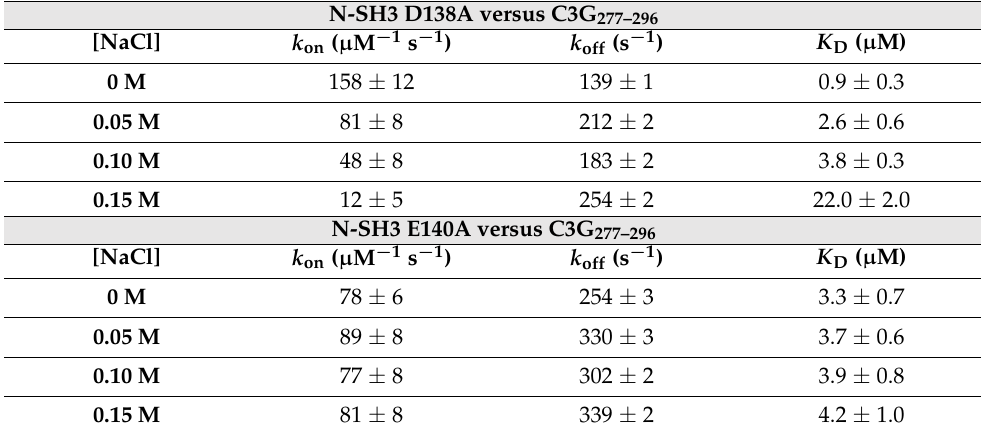
Figure 5. ( Top left ) Kinetic binding experiments performed by mixing a constant concentration of dansylated C3G 277–296 peptide (0.5 µ M) versus increasing concentrations of N-SH3 D138A at different ionic strength conditions (see legend). Lines are the best fit to Equation (1). ( Top right ) Kinetic binding experiments performed by mixing a constant concentration of dansylated C3G 277–296 peptide (0.5 µ M) versus increasing concentrations of N-SH3 E140A at different ionic strength conditions (see legend). Lines are the best fit to Equation (1). ( Bottom left ) Equilibrium binding experiment between N-SH3 D141A held at constant concentration and increasing concentrations of dansylated C3G 277–296 peptide. Line is the best fit to a hyperbolic function. ( Bottom right ) Average displacement trace obtained for D141A. See text for details of conditions used. Lines are the best fit to a single-exponential function. Table 2. Kinetic parameters obtained from linear fitting of data reported in Figure 5 (Top left, Top right ). Equilibrium dissociation rate constant K D were calculated as k off / k on